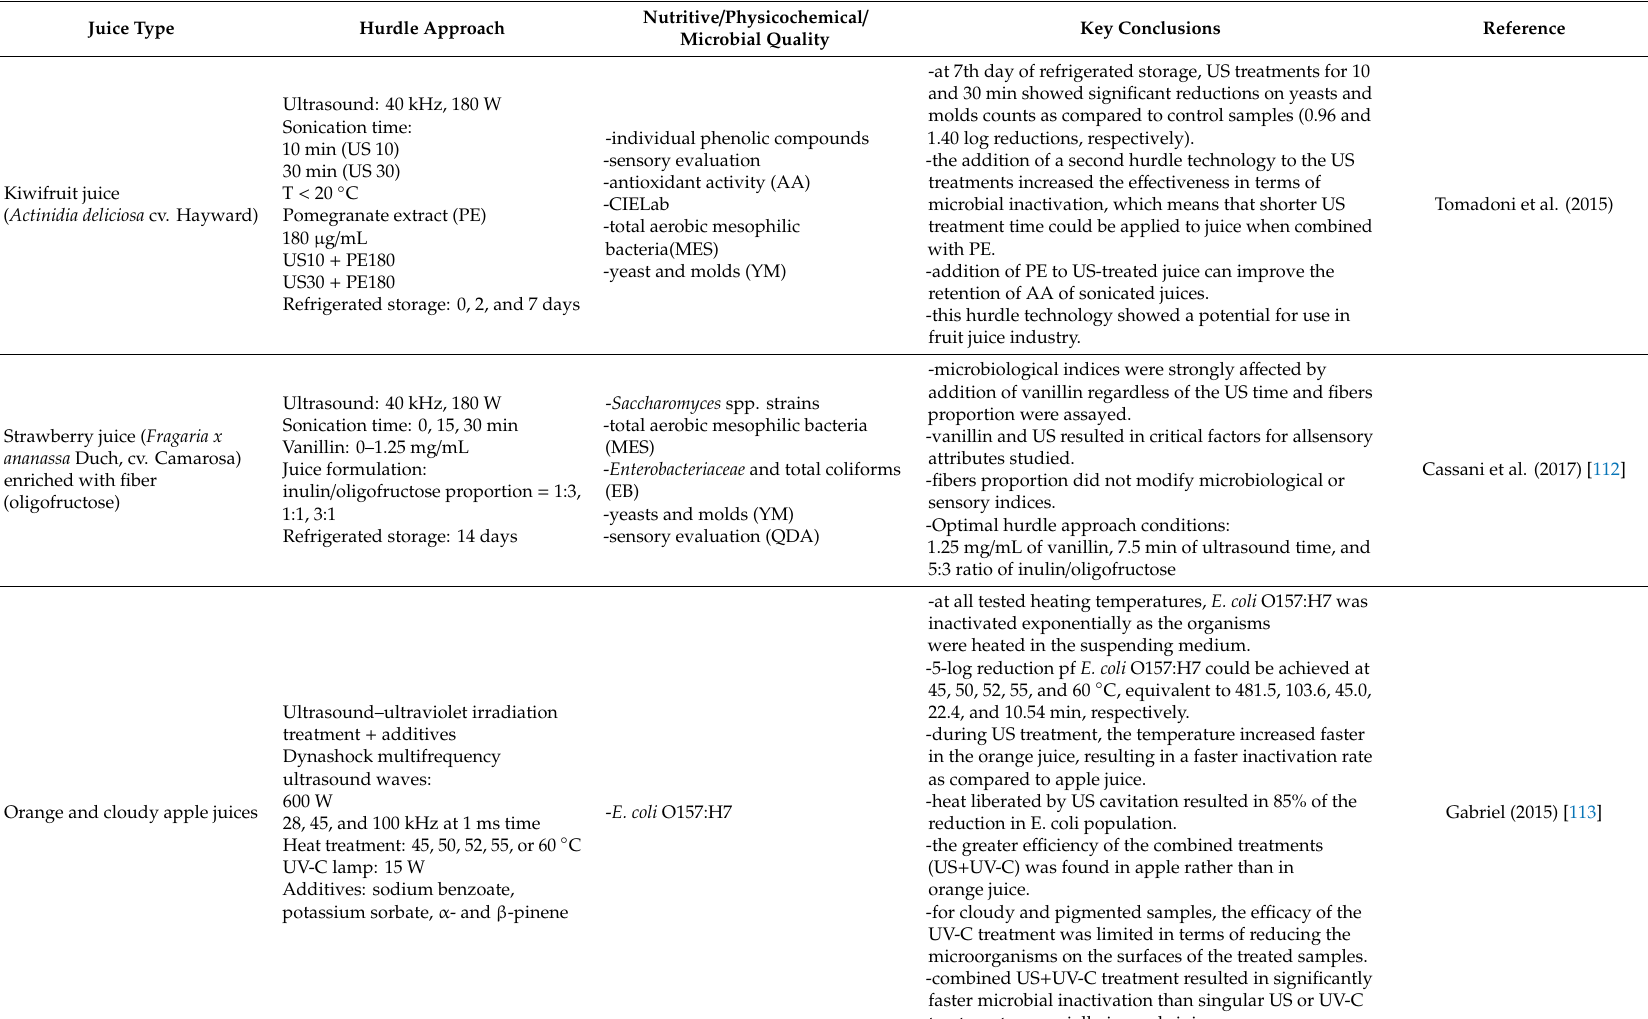
Table 4. The application of the hurdle approach for the preservation of functional fruit juices and beverages over the last 5 years. Juice